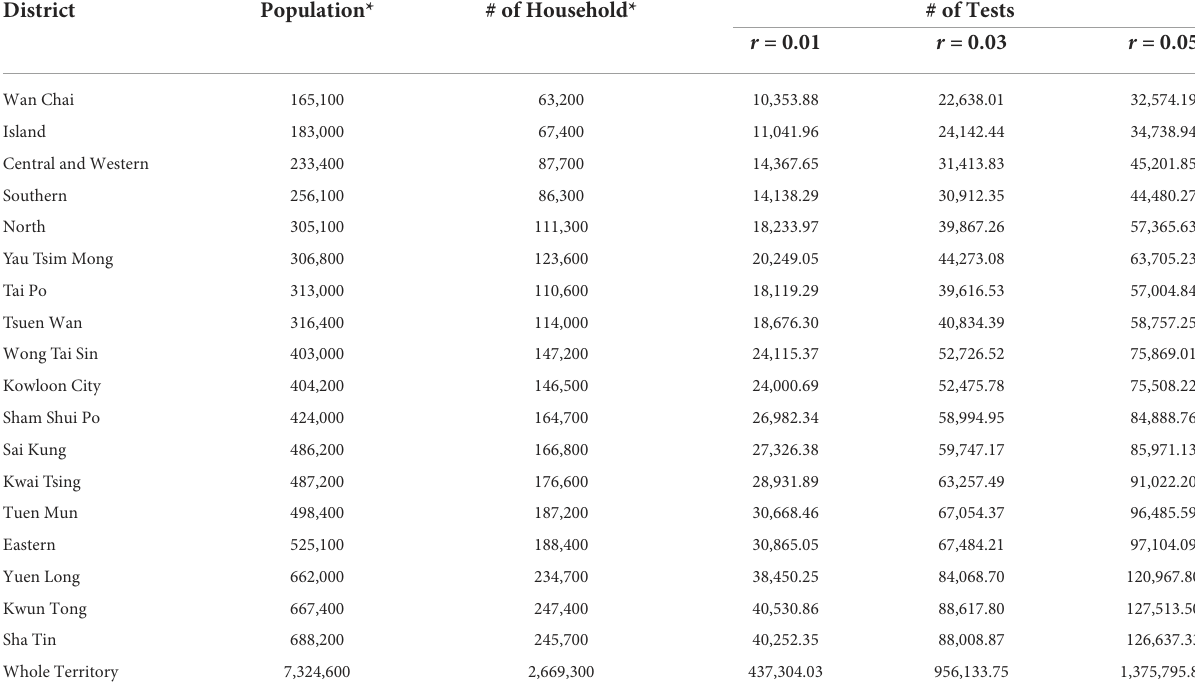
TABLE 4 Number of tests required for different districts and the prevalence rate in Hong